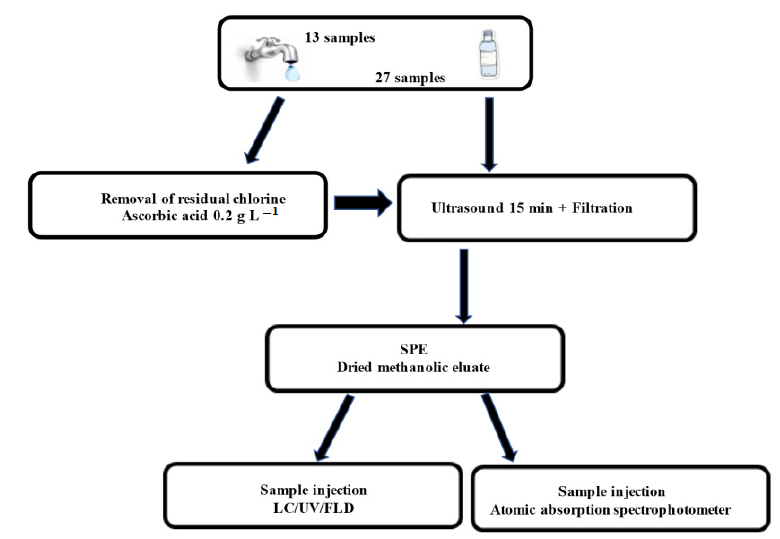
Figure 5. Samples preparation and analysis procedure.